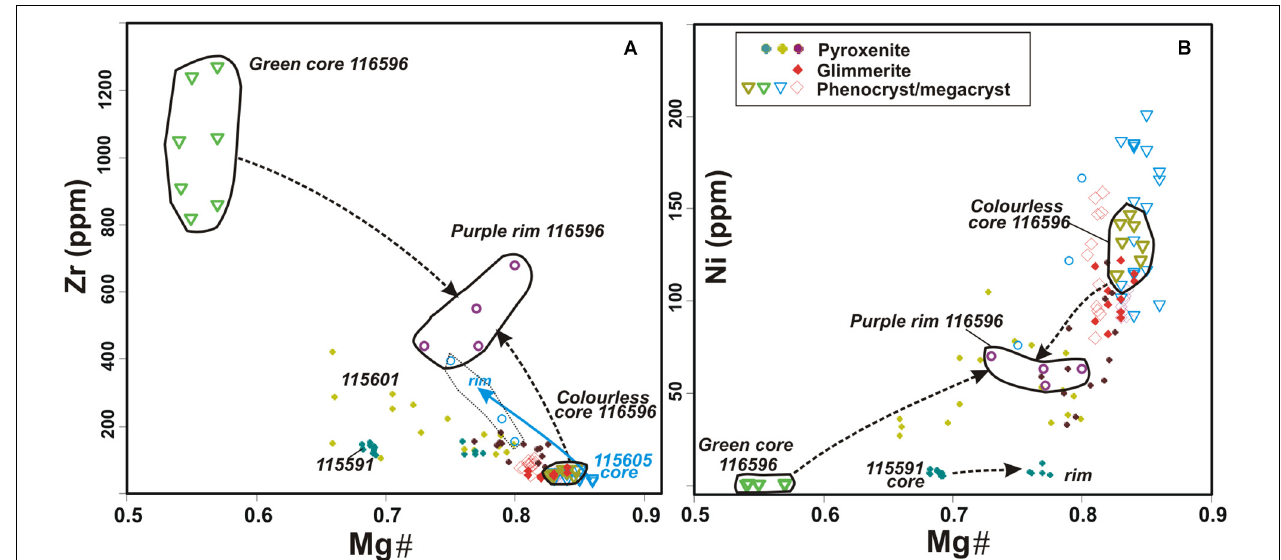
FIGURE 7 | Variation diagrams (Zr and Ni vs. Mg#) (Mg# = molecular MgO/(MgO+FeOt)) of the studied clinopyroxene populations. The arrows represent the zoning evolution from green and colorless cores toward purple rims of phenocrysts of the Cerro Pelado nephelinite 116596. A narrower core-to-rim chemical zoning of colorless phenocryst from the El Aprisco melilitite 115605 is also shown with a blue arrow (A) . Low-Mg greenish clinopyroxenes from El Aprisco 115591 [with core-to-rim zoning in panel (B) plot] and 115601 pyroxenites are also